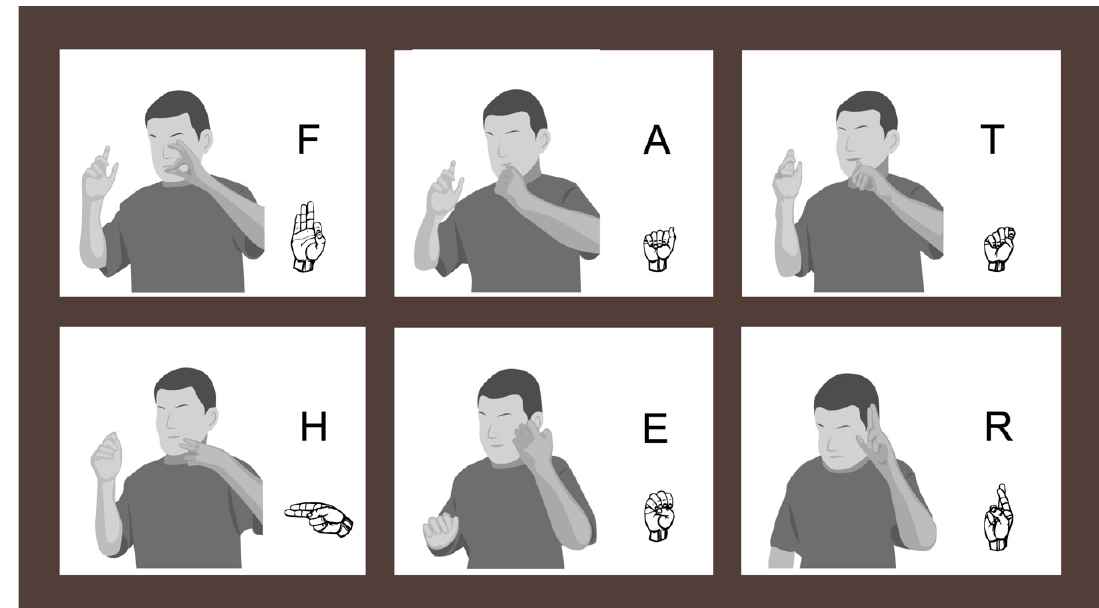
Figure 4. The fingerspelled word #FATHER produced on the left hand at 10;2 with correct outward palm orientation on the letter F, mid-facing orientation on the letter A, correct outward palm orientation on the letter T, correct inward orientation on the letter H, incorrect reversed palm orientation on the letter E, and correct outward palm orientation on the letter R. Note the lack of inhibition of movement of the non-signing right hand, indicative of a lack of motor control.